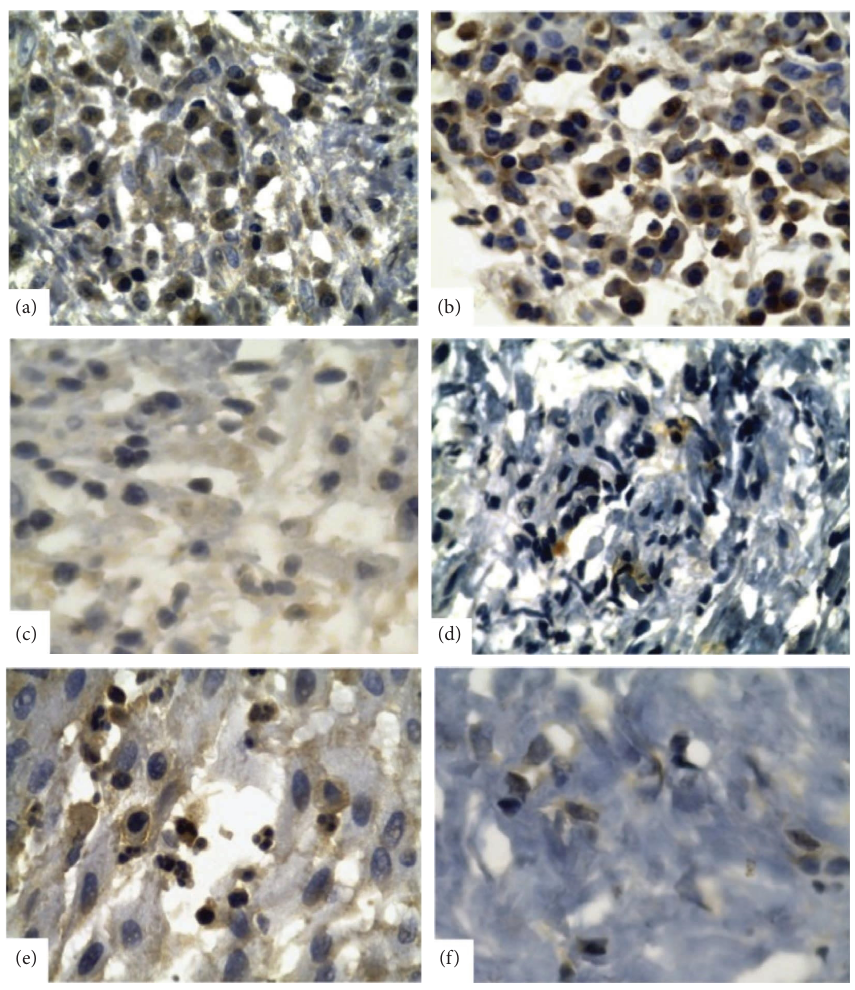
Figure 1: Photomicrographs of histological sections with the positive marking for proinfammatory cytokines in apical periodontitis lesions (immunoperoxidase; 40x). Diabetic patients-(a) IL-1 β , (b) IL-17, and (c) TNF- α . Control patients-(d) IL-1 β , (e) IL-17, and (f) TNF- α . Table 2: Comparison between proinfammatory cytokines in apical periodontitis